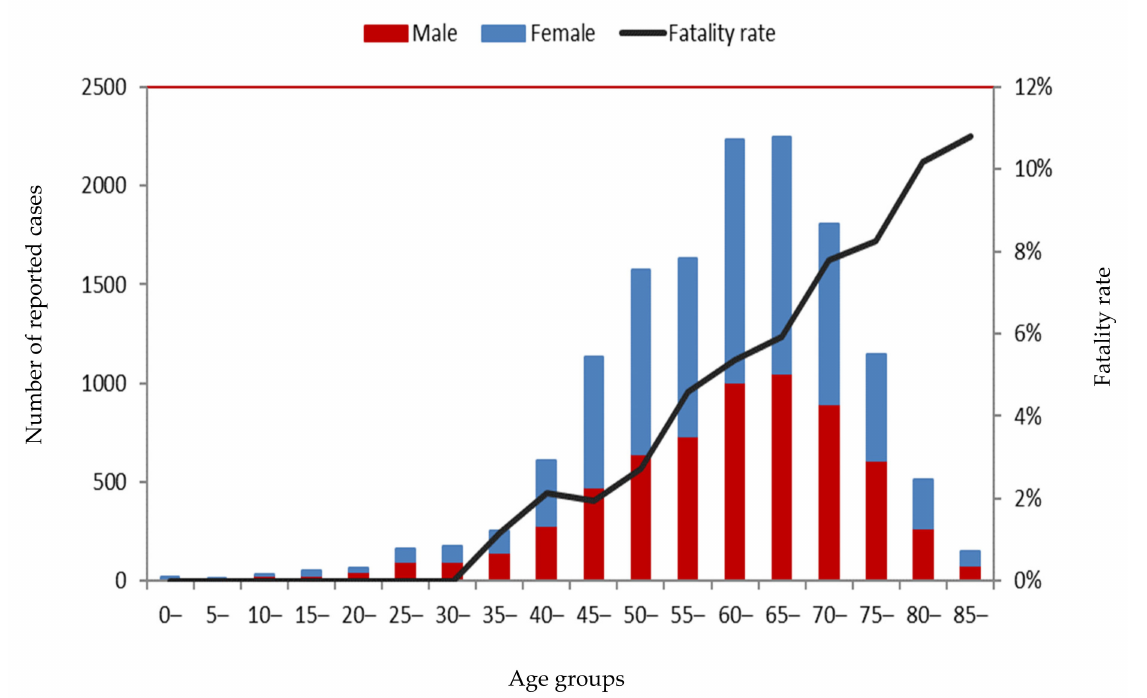
Figure 4. Population distribution of SFTS cases from 2010 to